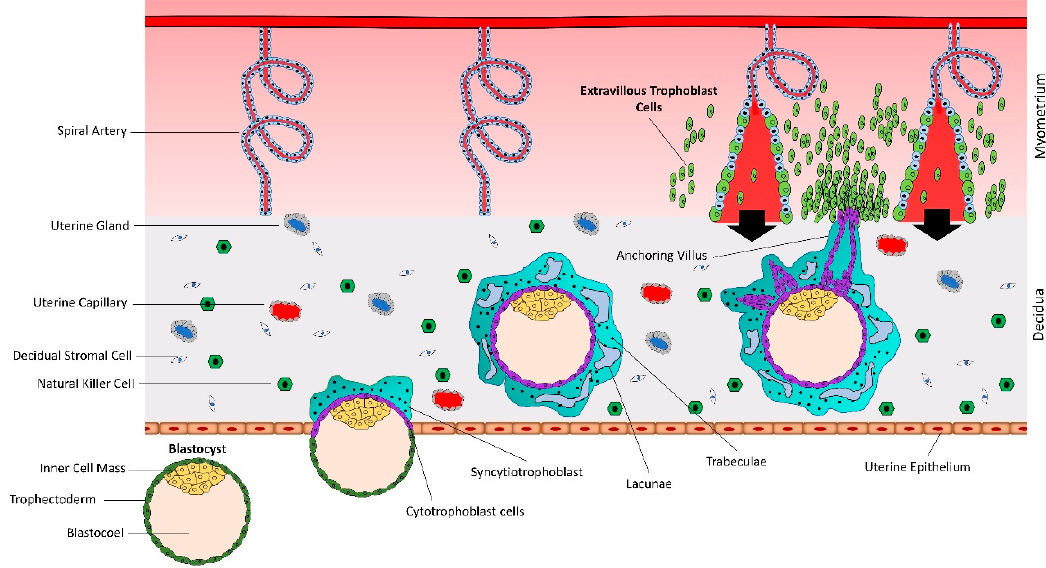
Figure 1. Early placental development and spiral artery remodeling. Human placental development starts with interaction between hatched blastocyst and uterine epithelium. The trophoblast cells that contact with the uterine epithelium transform into highly proliferative cytotrophoblasts (CTBs). Cytotrophoblasts undergo rapid proliferation and some of them fuse to form a multinucleated syncytiotrophoblast (STB). Within a few hours, STB expands and covers whole blastocyst and helps in blastocyst invasion into the uterine decidua. Continuous proliferation of CTBs results in formation of villi. Some CTBs from the tip of anchoring villi break the STB cover, invade the uterine stroma and myometrium, and transform into extravillous trophoblast cells (EVTs). EVTs remodel the spiral arteries to ensure sufficient flow of blood to the placenta.